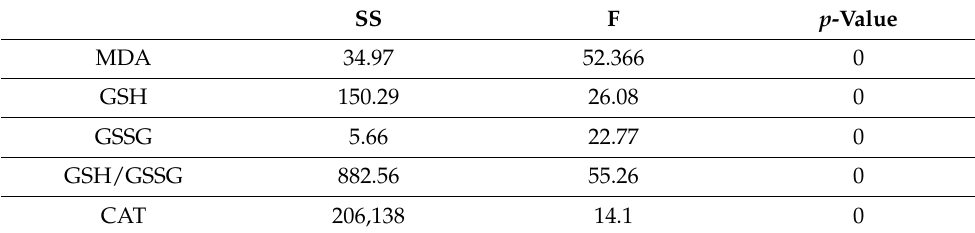
Table 1. Analysis of variance for all groups and all variables.